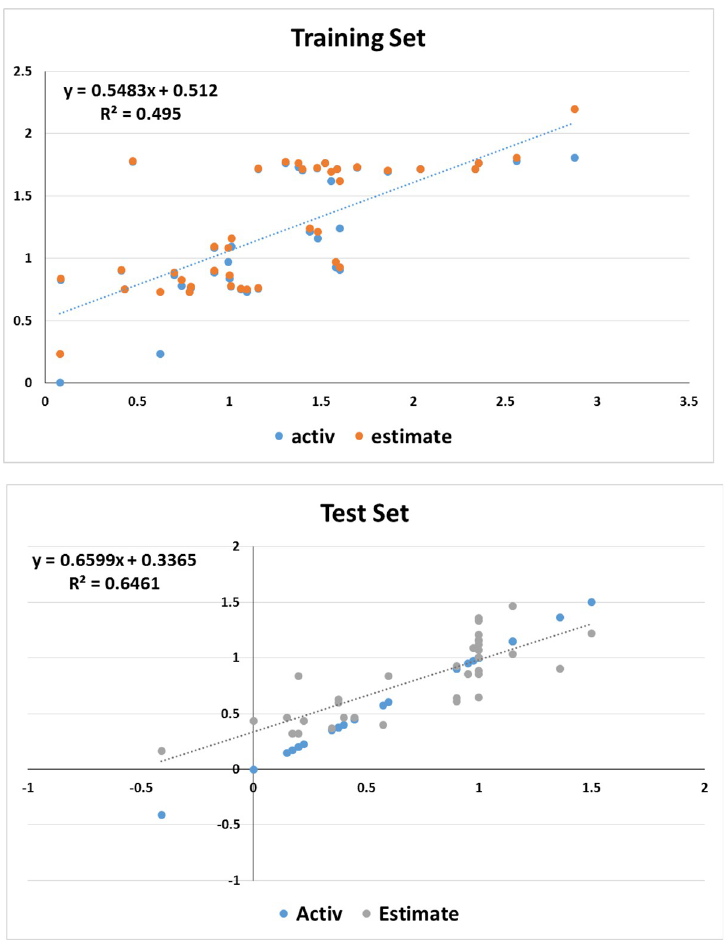
Fig 2. Correlation graph in logarithmic scale for experimental values vs. predicted values of training and test ligands that mapped the 3D-QSAR pharmacophore model Hypo1.